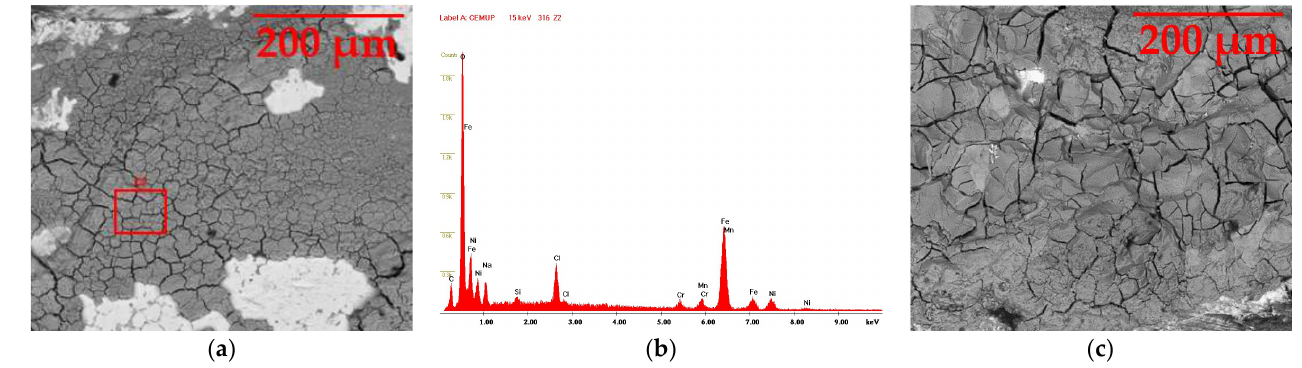
Figure 6. SEM image of the AISI 316L sample at a magnification of 500×: ( a ) after three weeks, ( b ) EDS of the red zone in the first image and ( c ) after three months.